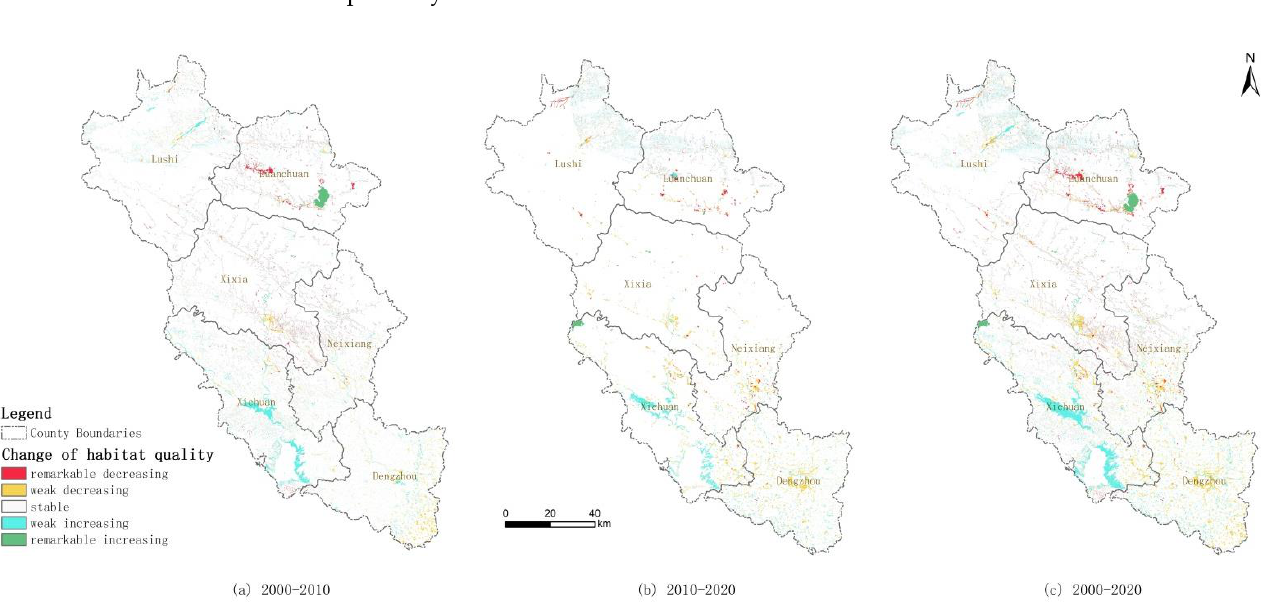
Figure 6. Spatial distribution of the changes of habitat quality. Table 6. Spatial transfer matrix of habitat quality in the study area (unit: km 2 ).